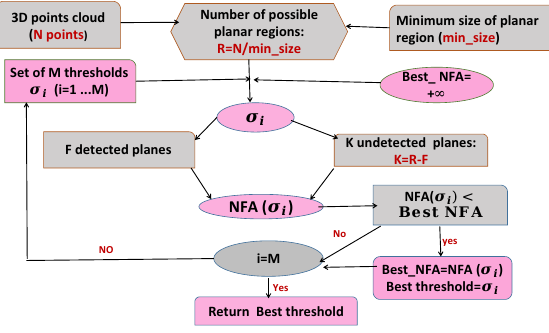
(min_size)Number of possible planar regions: